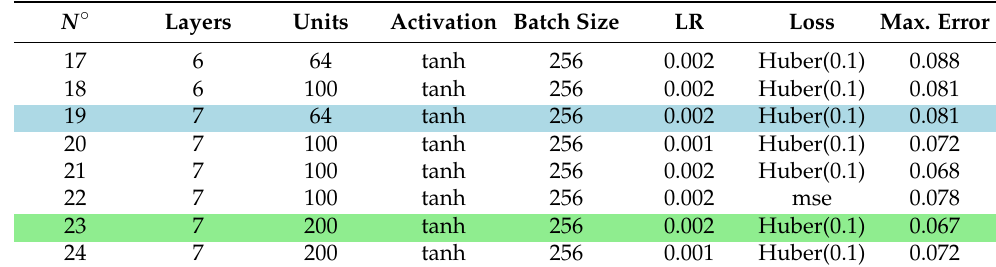
Table 6. Results of differents models for maximum heights with the ReduceLROnPlateau callback but without sigmoid activation function in the output layer. Blue rows are models with good results that will be use in ensemble models and the green row is the individual model